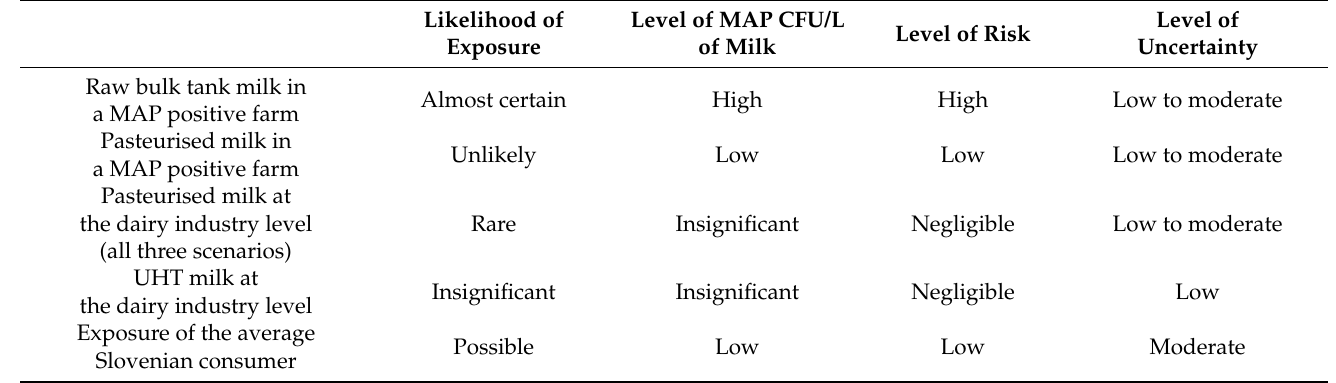
Table 4. Summary of risk characterisation by milk type and overall exposure of the average Slovenian consumer to Mycobacterium avium subsp. paratuberculosis